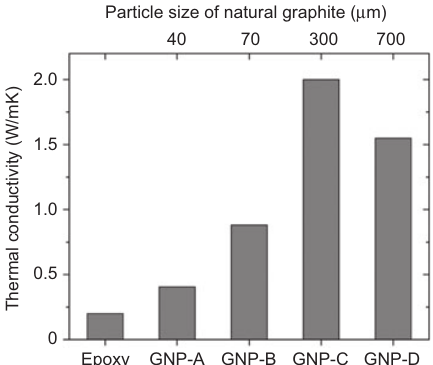
Figure 10 Thermal conductivities of neat epoxy and GNP-epoxy composites with different GNP fi llers at 10 wt % fi ller